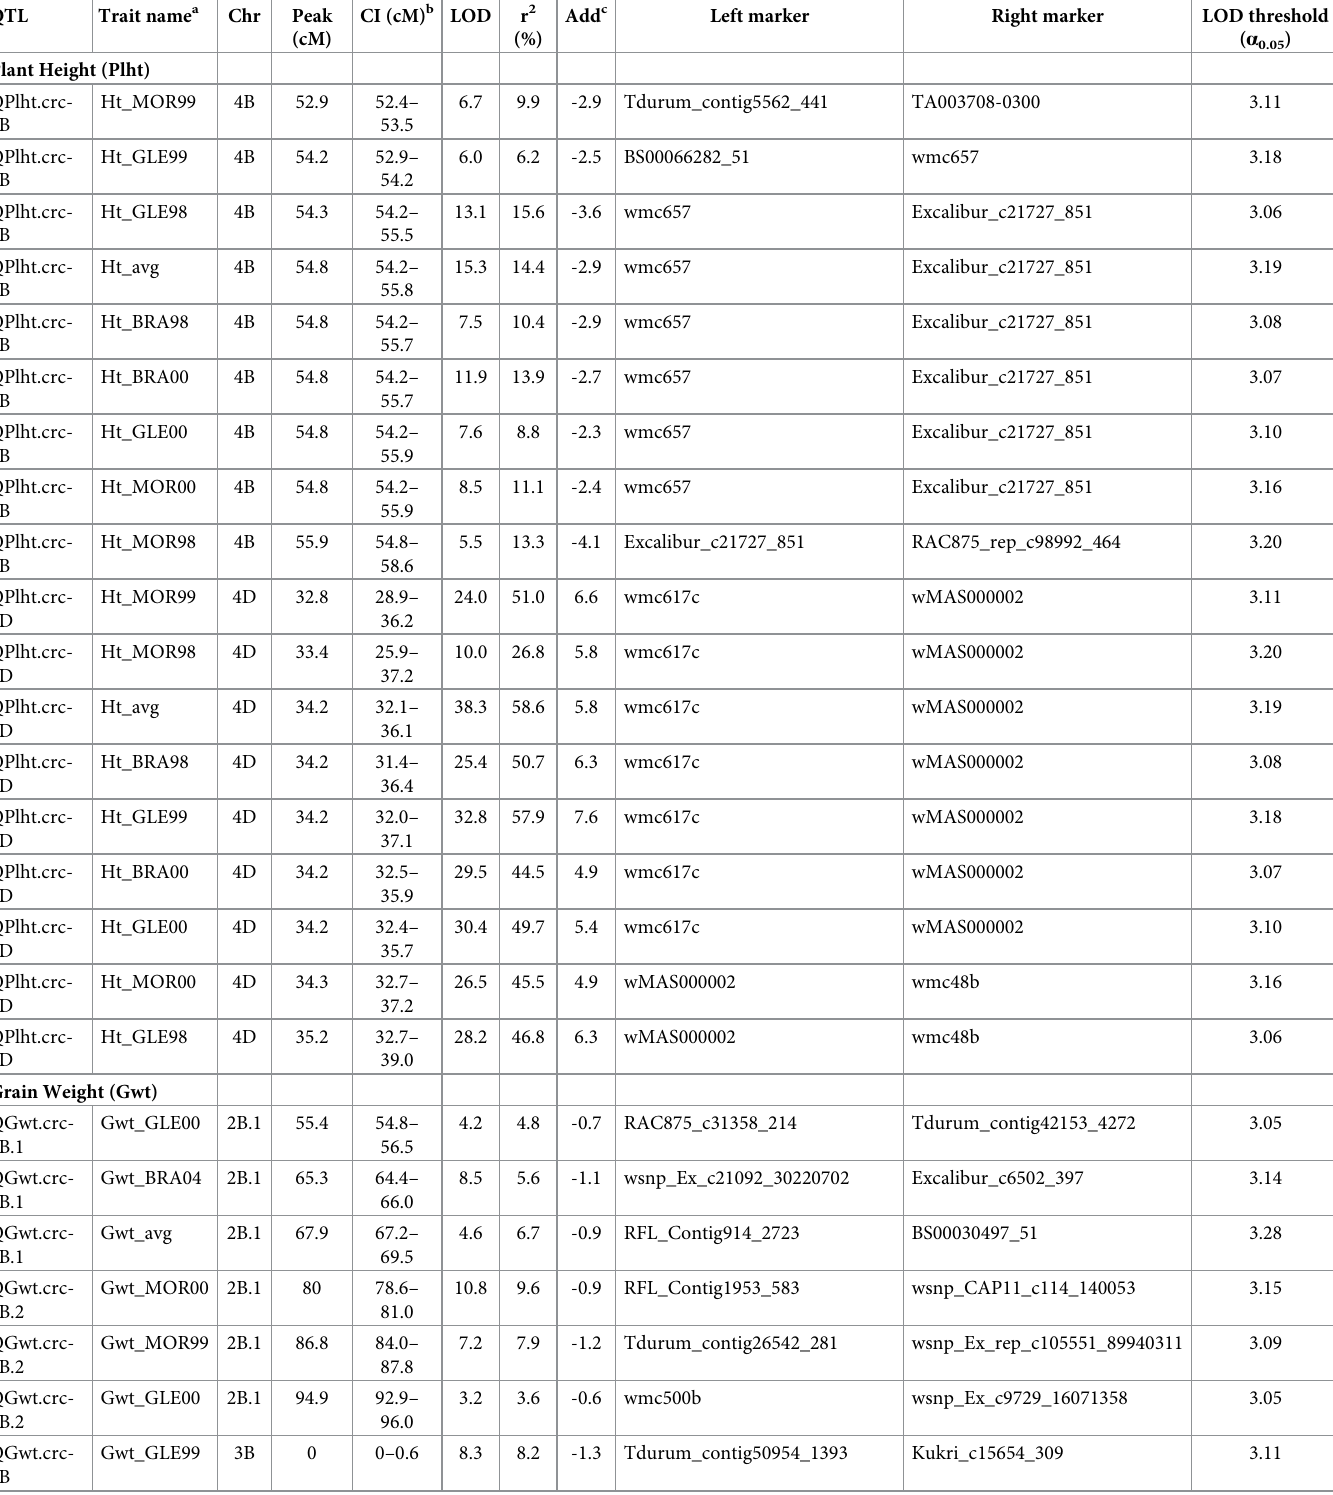
Table 2. Inclusive Composite Interval Mapping (QIC) of Plant height (Plht), Grain weight (Gwt), Test weight (Twt), and Flour yield (Fyd) QTL identified in the RL4452/‘AC Domain’ DH population grown in replicated multi-year trials.